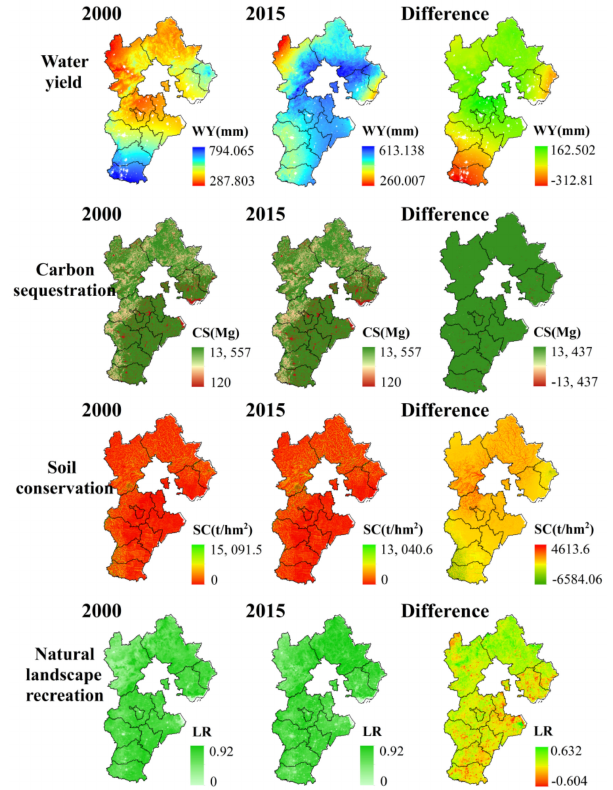
Figure 4. The spatiotemporal distribution and difference of water yield, carbon sequestration, soil conservation, and natural landscape recreation in Hebei during